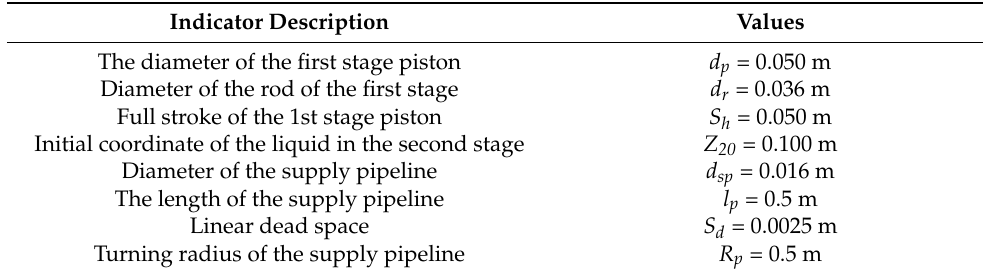
Table 1. Main dimensions PHPM.